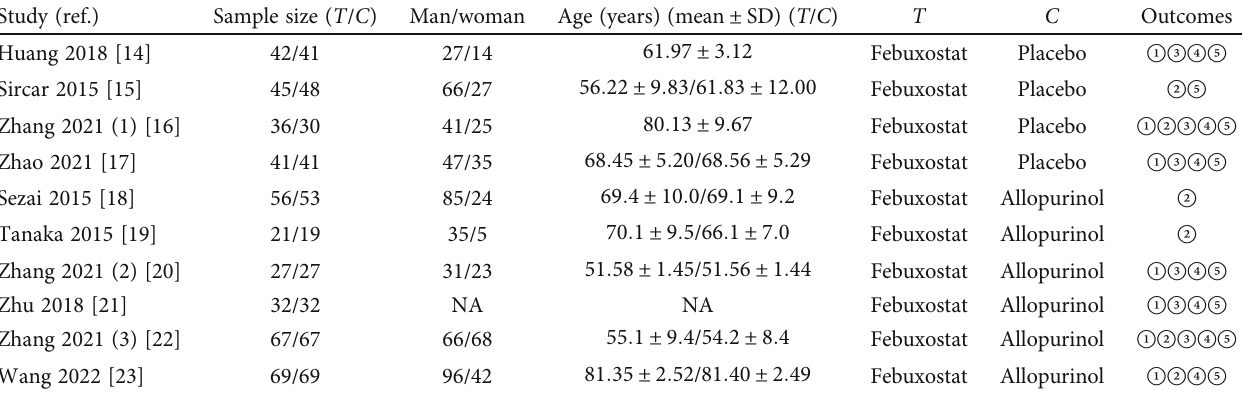
Table 1: Baseline characteristics.